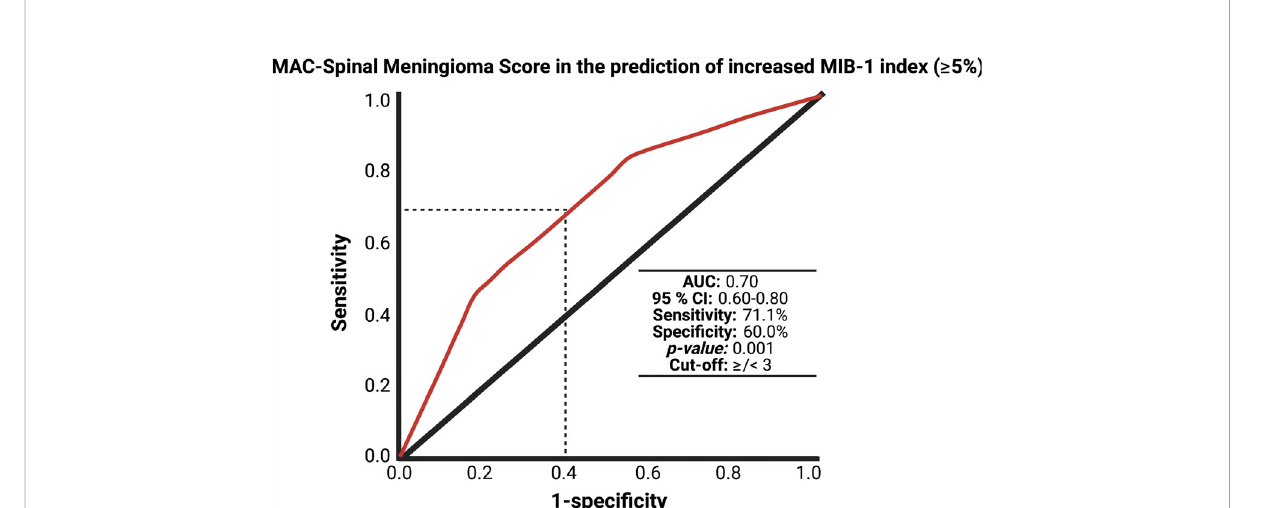
FIGURE 5 Receiver-operating characteristic curve demonstrating the MAC-Spinal Meningioma Score in the prediction of increased MIB-1 labeling index of sporadic spinal meningiomas. The dashed line marks the identi fi ed optimum cut-off value of the MAC-Spinal Meningioma score in the prediction of an increased MIB-1 labeling index ( ≥